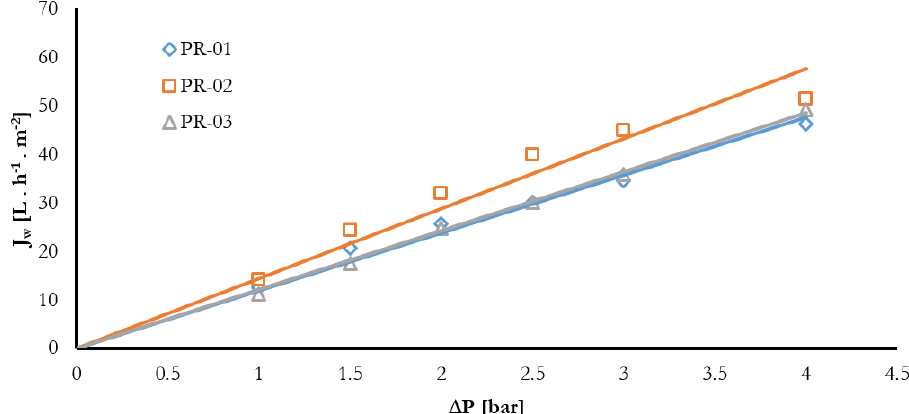
Figure 13. Pure water flux (Jw) as a function of trans-membrane pressure and PVDF-co-HFP amount (20% of total PVDF) with NMP as the solvent. Table 5. Pure water permeability and permeate vapor flux of PVDF under the DCMD test using pure water as a feed and as a